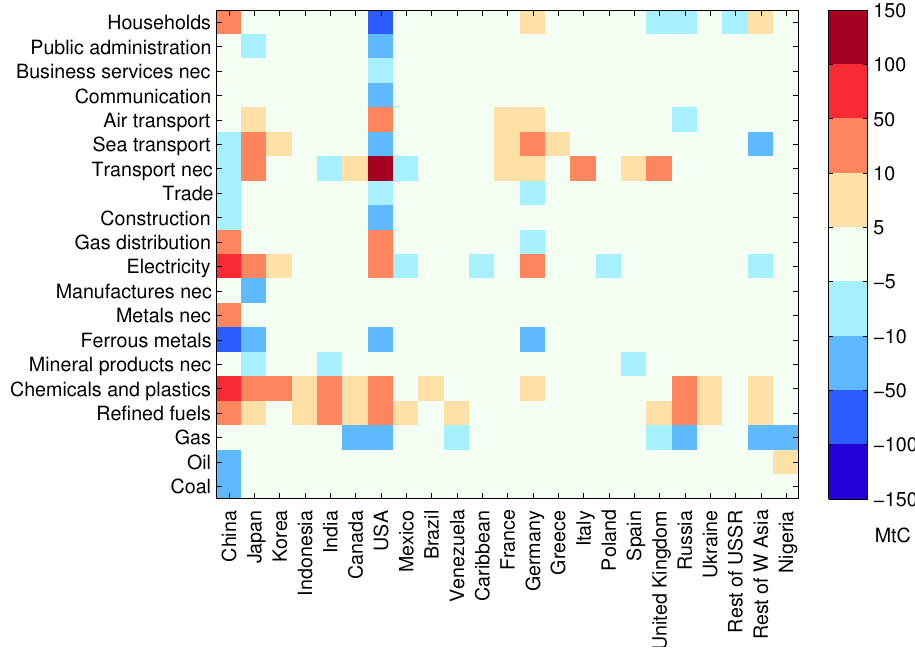
Fig. 3. The difference between the default GTAP CO 2 emission dataset and the EDGAR dataset with the sectors reallocated to the GTAP sectors. The differences are shown by sector and region and are inMtC for 2004. Positive values indicate that “GTAP” is larger. We only show the sector and region combinations where the difference is greater than